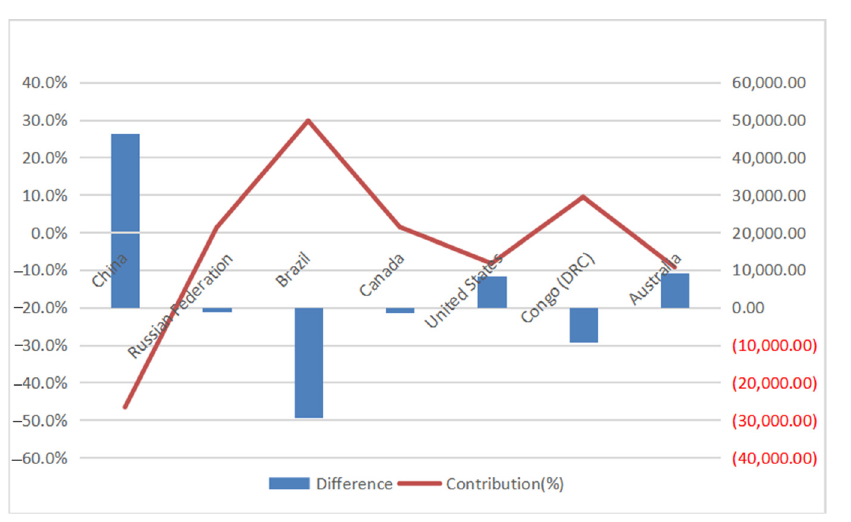
Figure 4. Forest area change and contribution to world forest area.